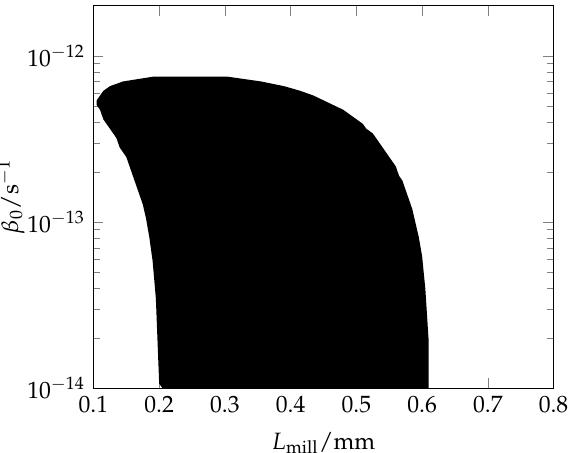
Figure 4. Stability map for the nominal parameter case. In the white region a stable steady states exists, in the black region an unstable stable steady state and a stable limit cycle